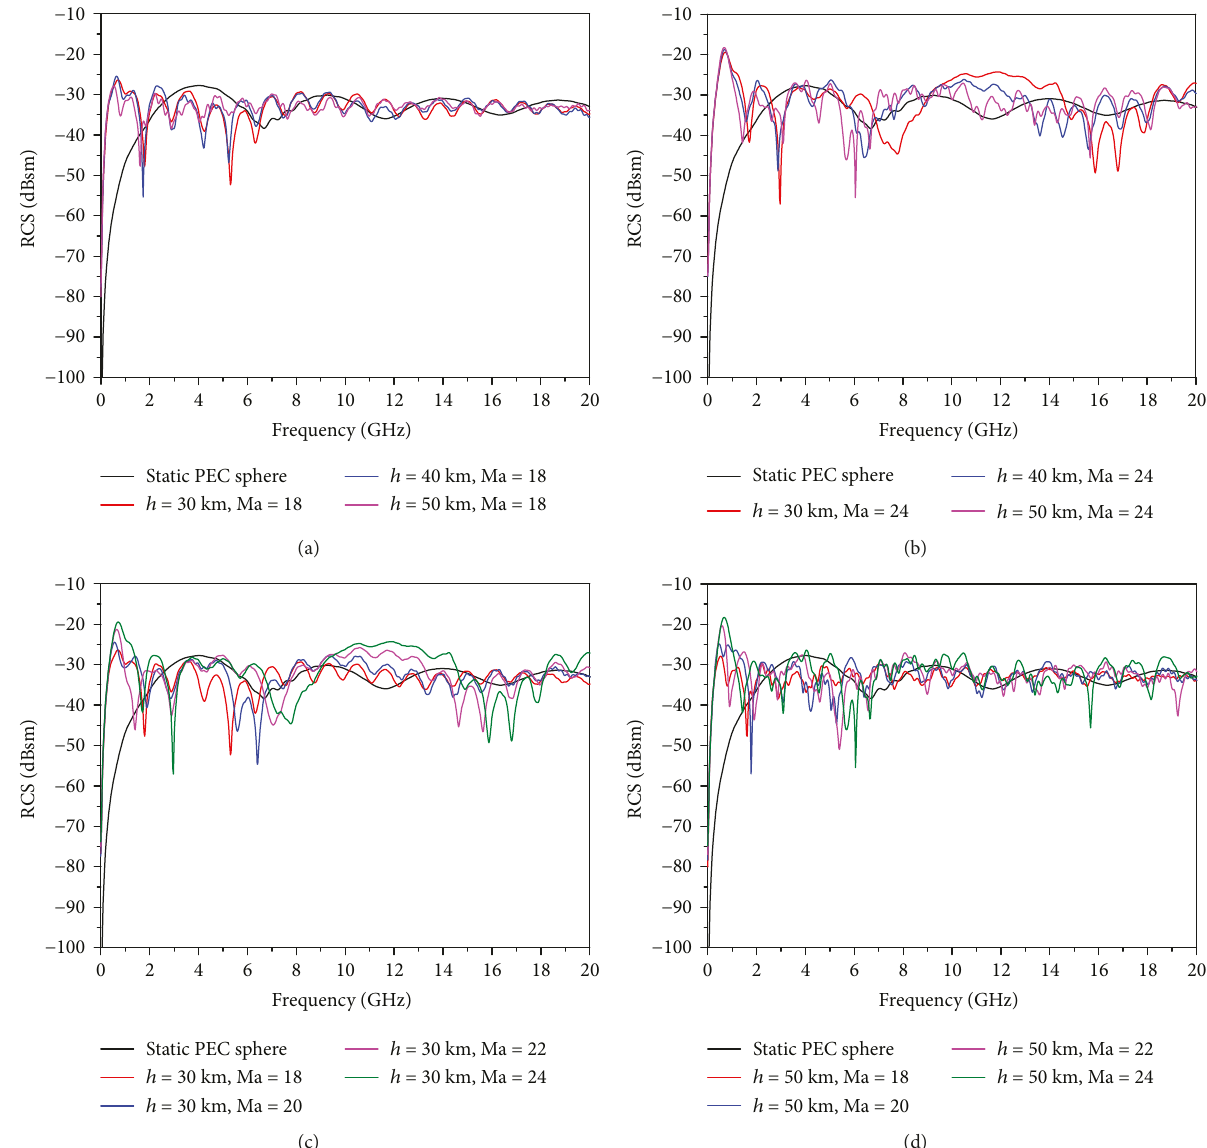
Figure 7: Distributions of backward RCS against frequency for a hypersonic sphere enveloped by a plasma fl ow illuminated by a polarized plane wave with incident angles ( θ = 90 0 ∘ , φ = 0 0 ∘ ). HH RCS components are plotted for di ff erent fl ight conditions. (a) Di ff erent heights, Ma = 18 ; (b) di ff erent heights, Ma = 24 ; (c) h = 30 km, di ff erent velocities; (d) h = 50 km, di ff erent